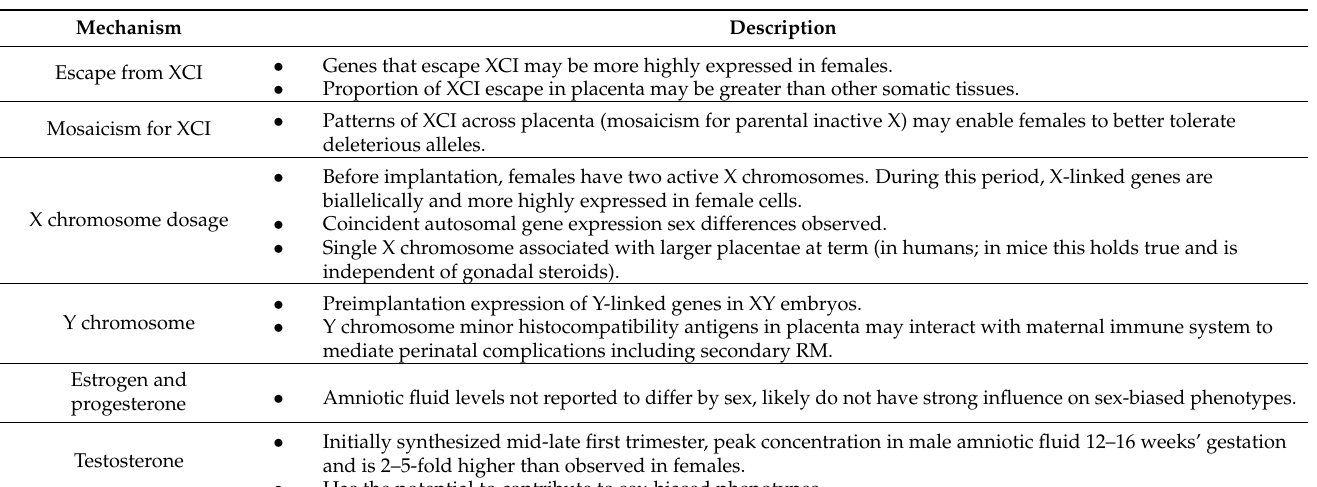
Table 4. Mechanisms underlying sex differences across gestation, XCI indicates X-chromosome inactivation.